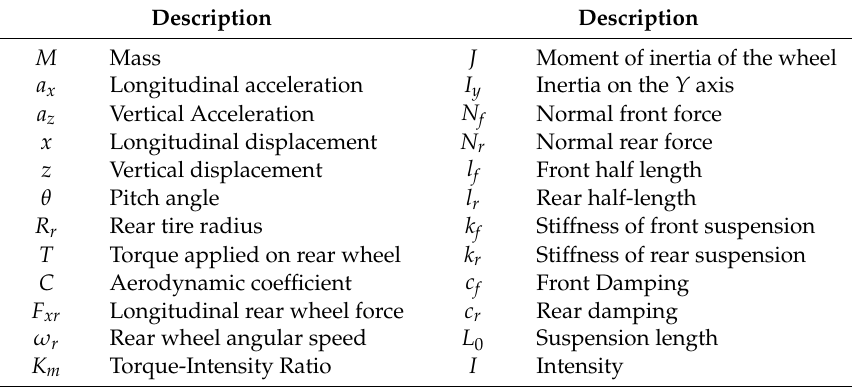
Table 1. Motorcycle model parameters.